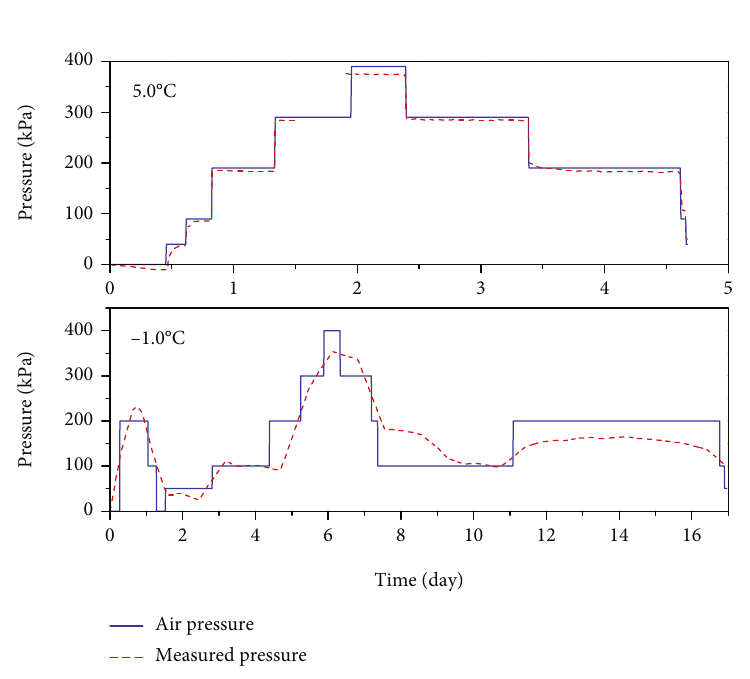
Figure 8: Connectivity test result for frozen soil at 5 ° C and -1.0 ° C (KY-01 and